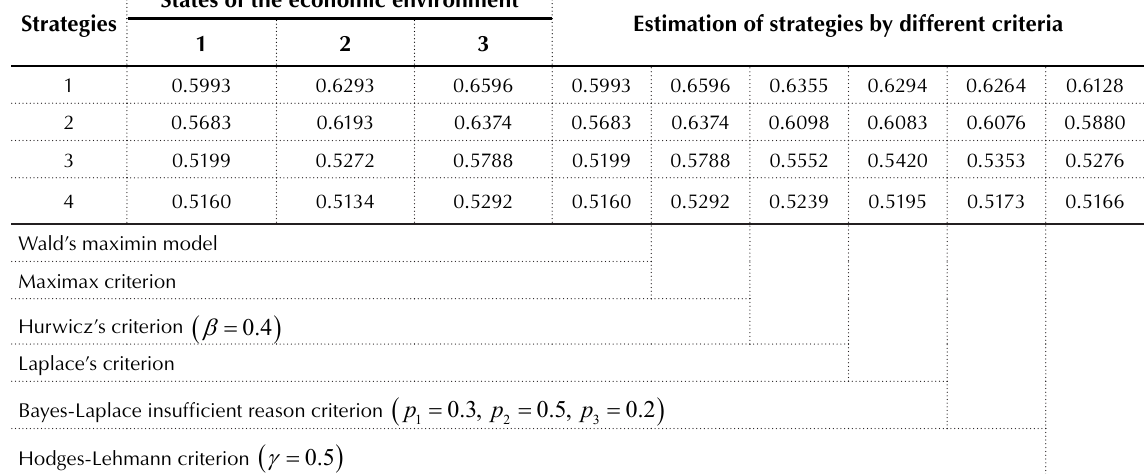
Estimation of strategies by different criteria